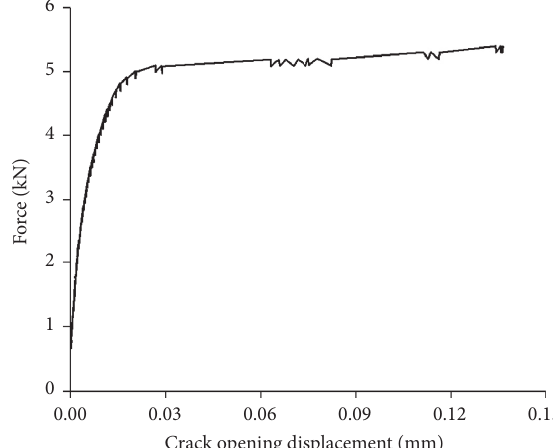
Figure 4: Typical force versus crack opening displacement curve of rock